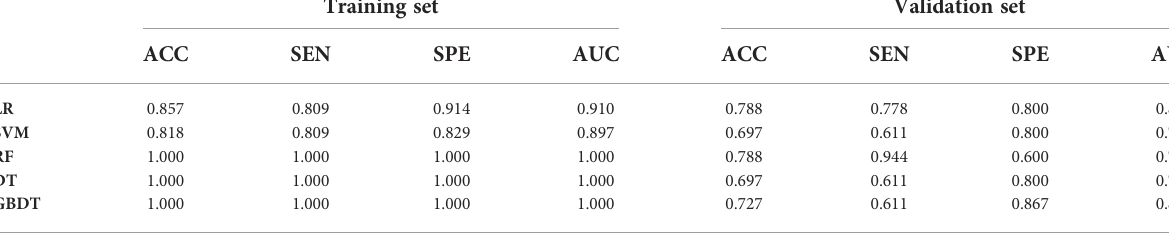
TABLE 3 Predictive performance of training and validation sets for fi ve machine learning models.